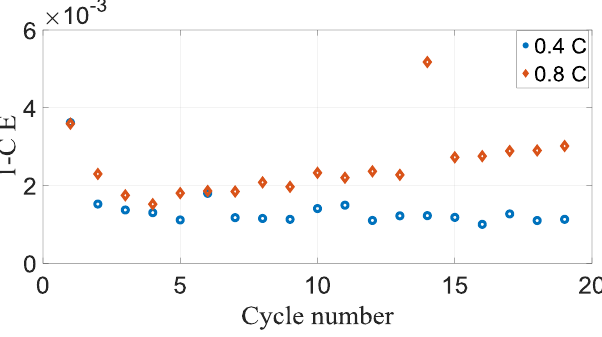
Figure 5. Coulombic inefficiency vs cycle number.